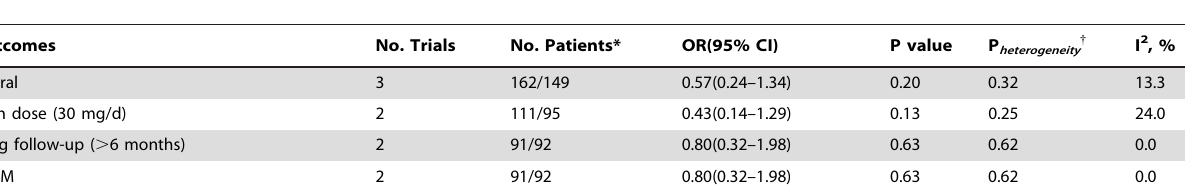
Table 3. Sensitivity Analyses for